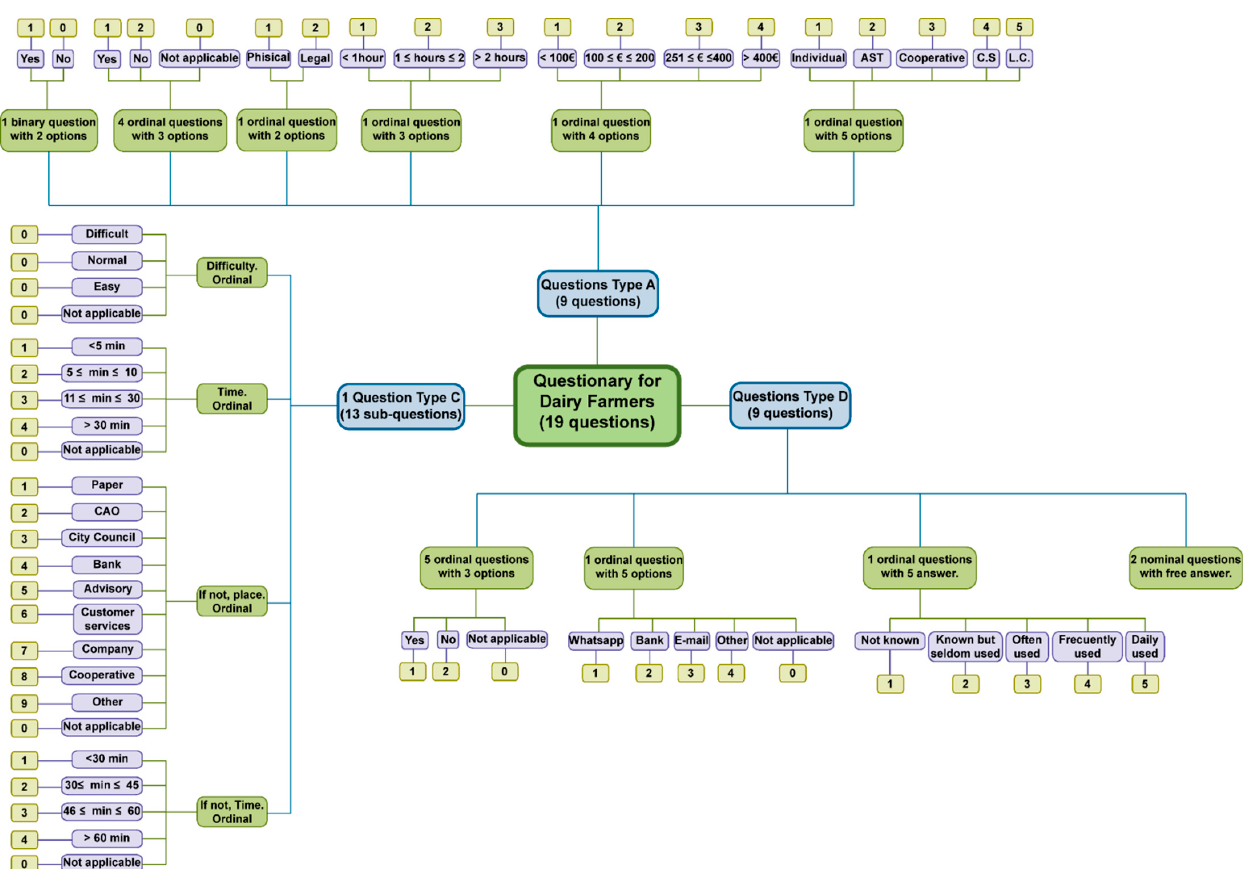
Figure 5. Typology of Questions. Codification.